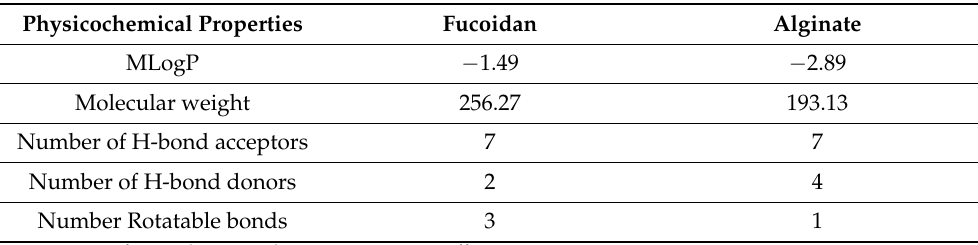
Table 1. Analysis of swissADME for marine bioactive compounds (fucoidan and